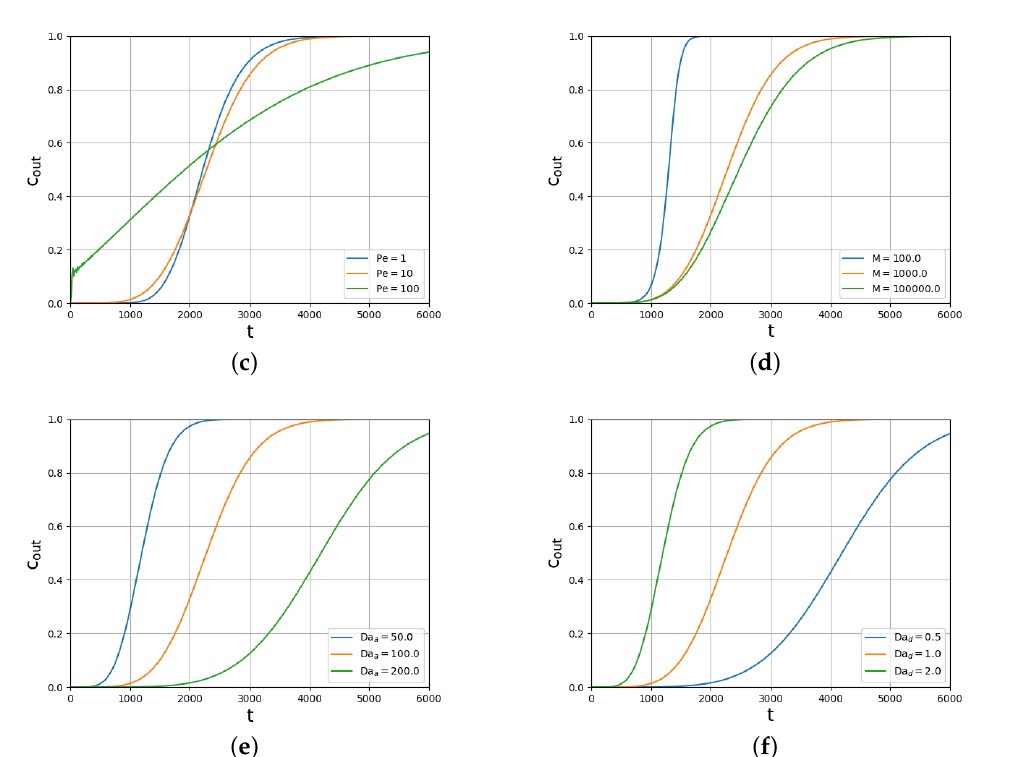
Figure 3. Research on: ( a ) computational grids of different densities, ( b ) different time steps, ( c ) dif- ferent Peclet numbers, ( d ) different maximum concentrations adsorbed on the surface, ( e ) different Damköler numbers for adsorption, ( f ) different Damköler numbers for